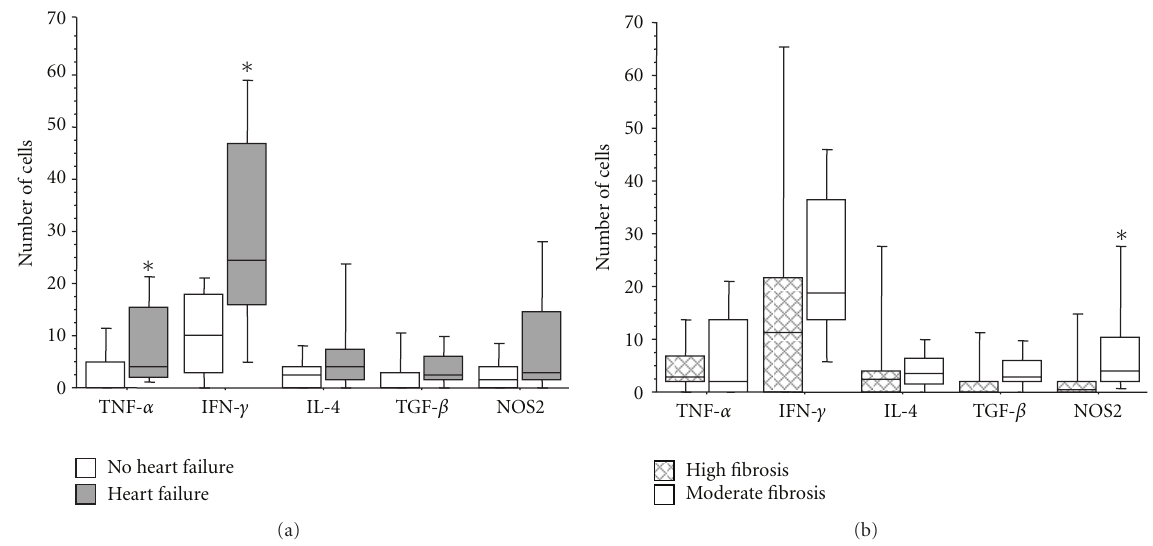
Figure 2: Number of inflammatory cells expressing cytokines and NOS2 in heart tissue from patients in the chronic phase of Chagas’ disease. (a) Subjects were divided according to the presence (gray bar) or absence of heart failure (open bar). (b) Subjects were divided according to the presence of a high degree (hatched bar) or low degree of fibrosis (open bar). Horizontal lines represent the median, boxes represent the 25th to 75th percentiles, and vertical lines indicate the 10th to 90th percentiles. ∗ P < 0 . 05 (Mann-Whitney test).